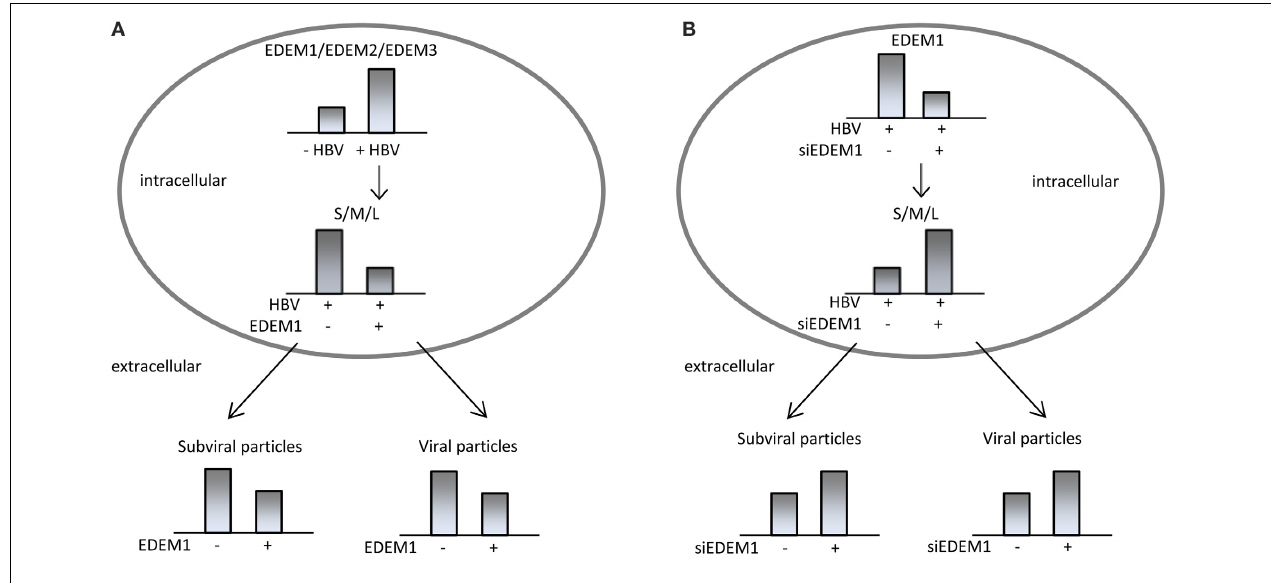
FIGURE 2 | HBV interaction with the ER-associated degradation pathway. HBV activates expression of EDEMs, which promote degradation of wild-type, assembly-competent HBV surface proteins, reducing the